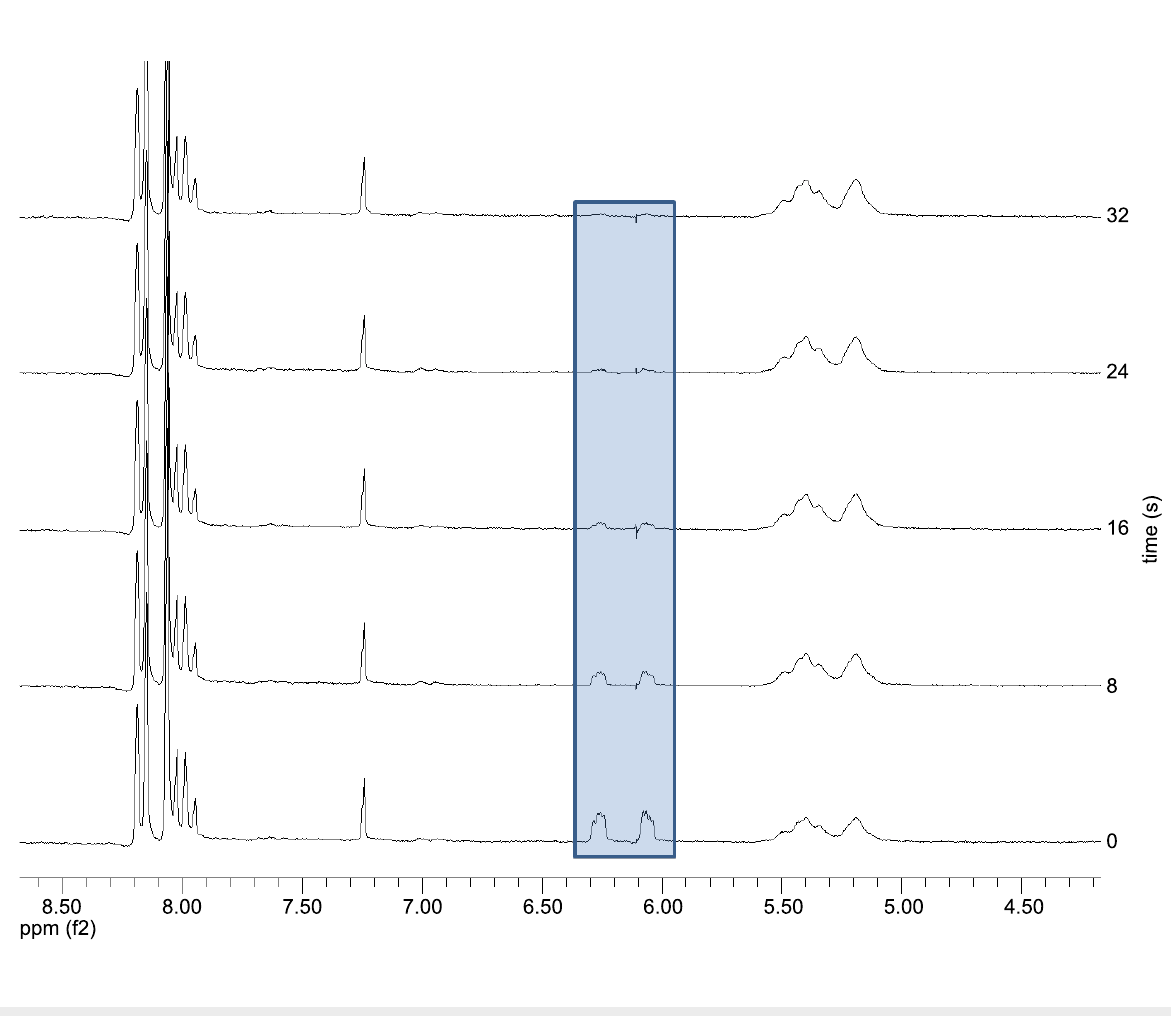
Figure 4: Kinetic progress monitored via 1 H NMR spectroscopy of the polymerization of 7 with catalyst U3 ; [ 7 ]/[ U3 ] = 20/1.